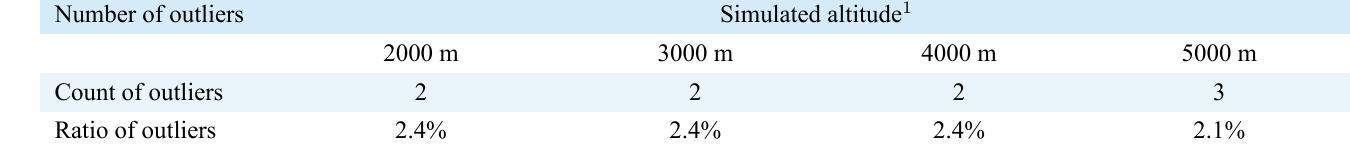
TABLE 5. The ratio of outliers.